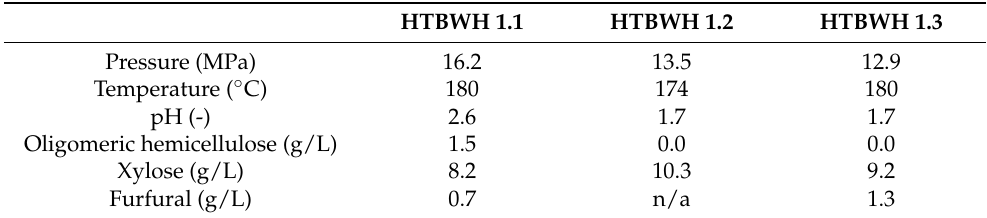
Table 3. Composition of the hydrothermally treated beechwood hydrolyzate 1 (HTBWH) at different process